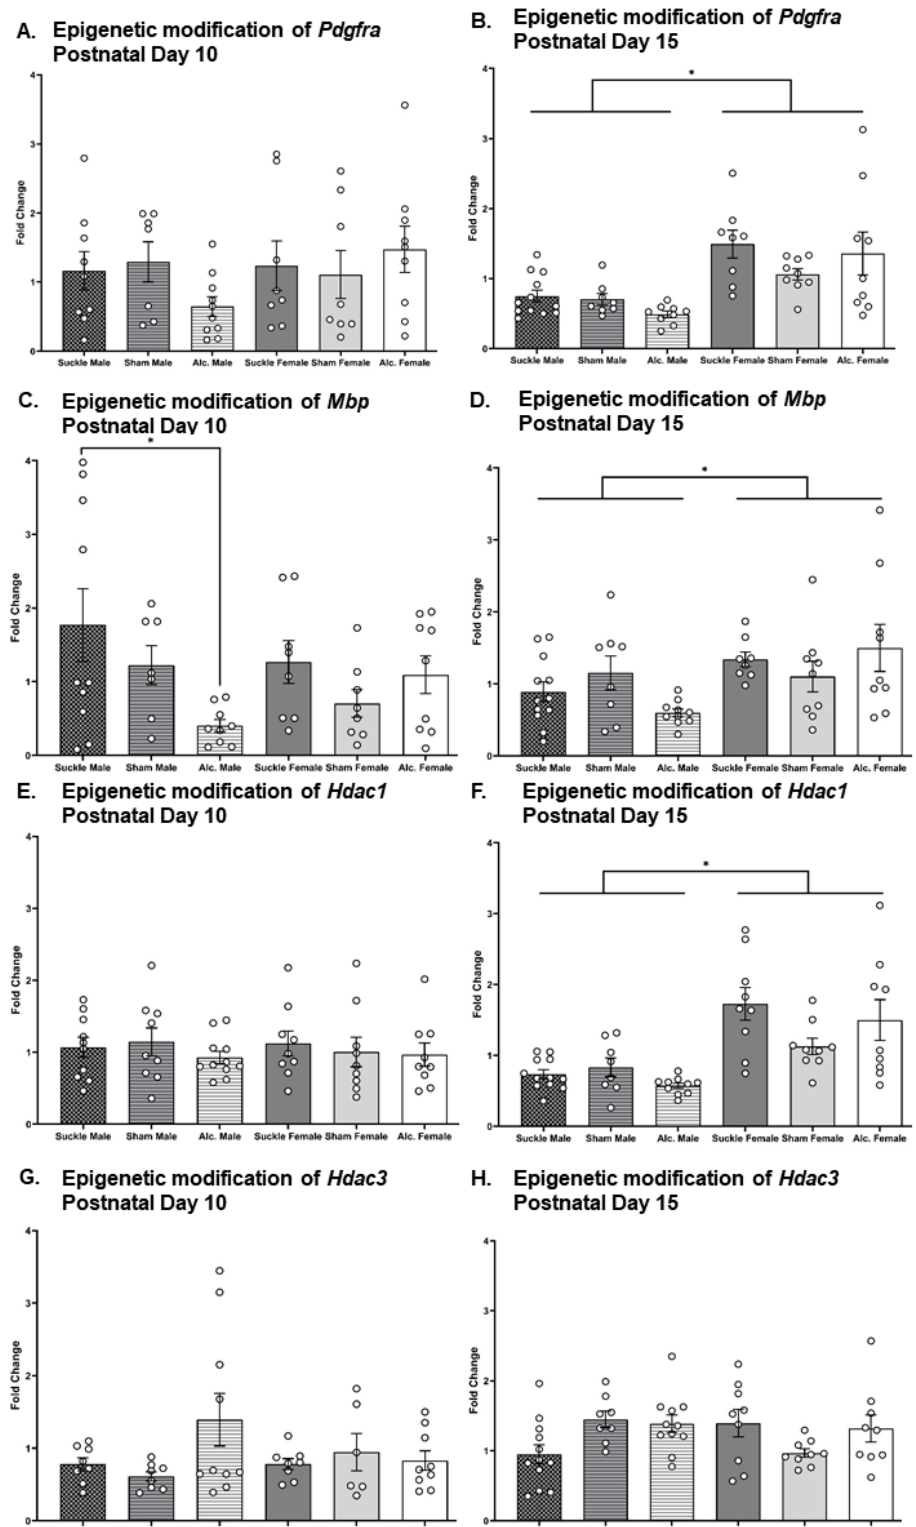
Figure 7. Fold change of Pdgfra , Mbp , Hdac1 , and Hdac3 genes on PD 10 relative to that observed in suckle control rats from analogous groups ( A , C , E , G , respectively) and 15 ( B , D , F , H , respectively). * p ≤